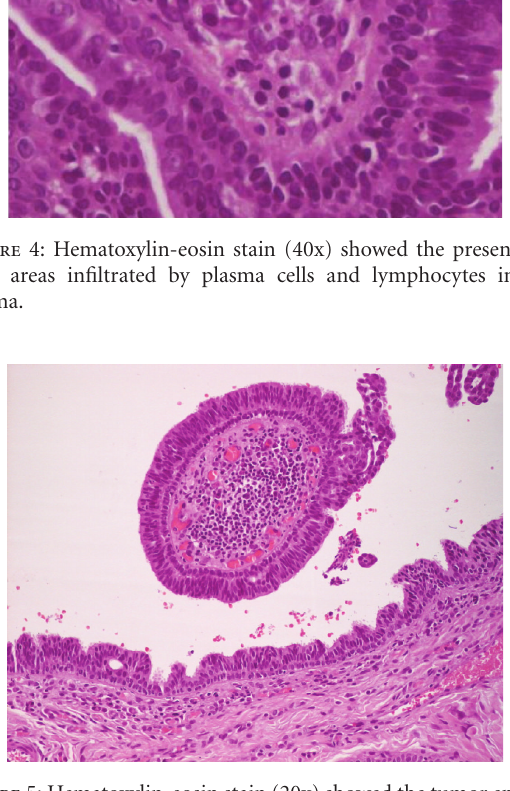
Figure 5: Hematoxylin-eosin stain (20x) showed the tumor epithe- lium to be composed by an outer cuboidal cell layer and an inner columnar cell